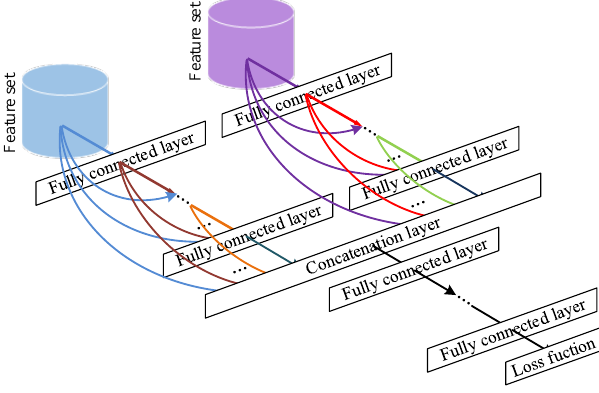
Figure 5. The overall architecture of the two-stream deep feature fusion